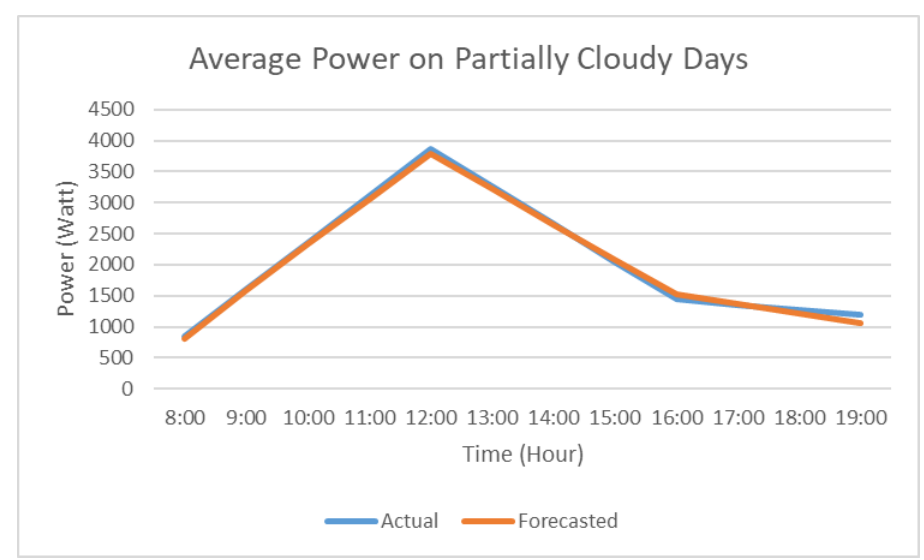
Figure 8. Actual versus forecasted curve of average solar power for WT-ANFIS-HFPSO on partially cloudy days.